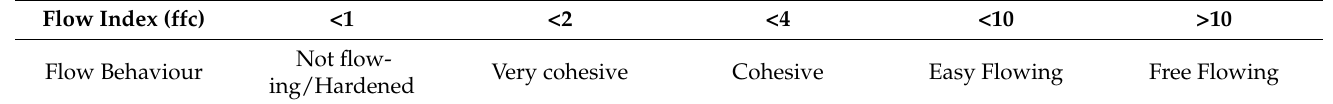
Table 7. Jenike classification of powder flowability (Adapted from ref. [19]).